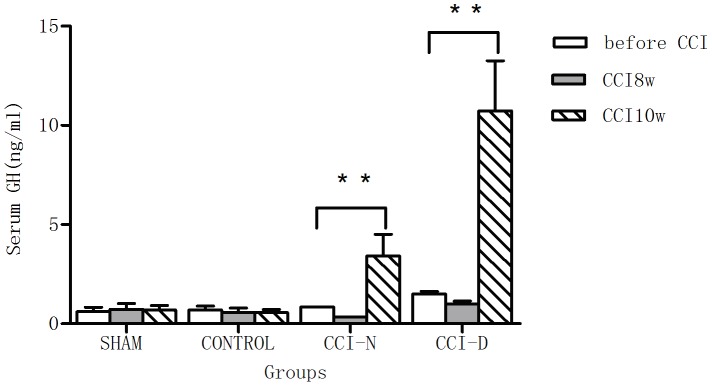
GH levels at different time points.Note: ** indicated as p<0.01 between different time points.